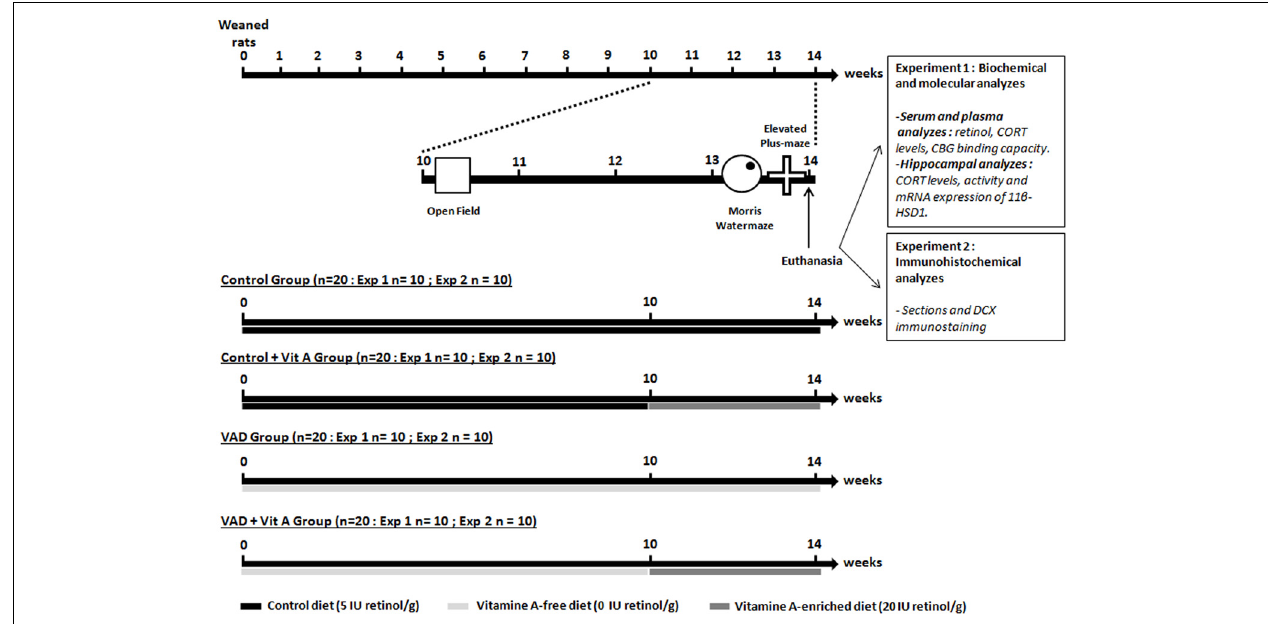
FIGURE 1 | Experimental design. The weaned rats were fed with a control diet containing 5IU retinol/g or a vitamin A-deficient diet for 10 weeks until the open-field test. From the 10thweek of VAD, half of the animals was supplemented with a vitamin A-enriched diet (20IU retinol/g) for 4 weeks (Control, VAD, Control + Vit A, VAD + Vit A). After euthanasia, the first experiment (Exp 1) investigated the effects of 14 weeks of VAD and a 4-week vitamin A supplementation on retinoid and GCs status both at the peripheral levels (serum retinol, plasma CORT,